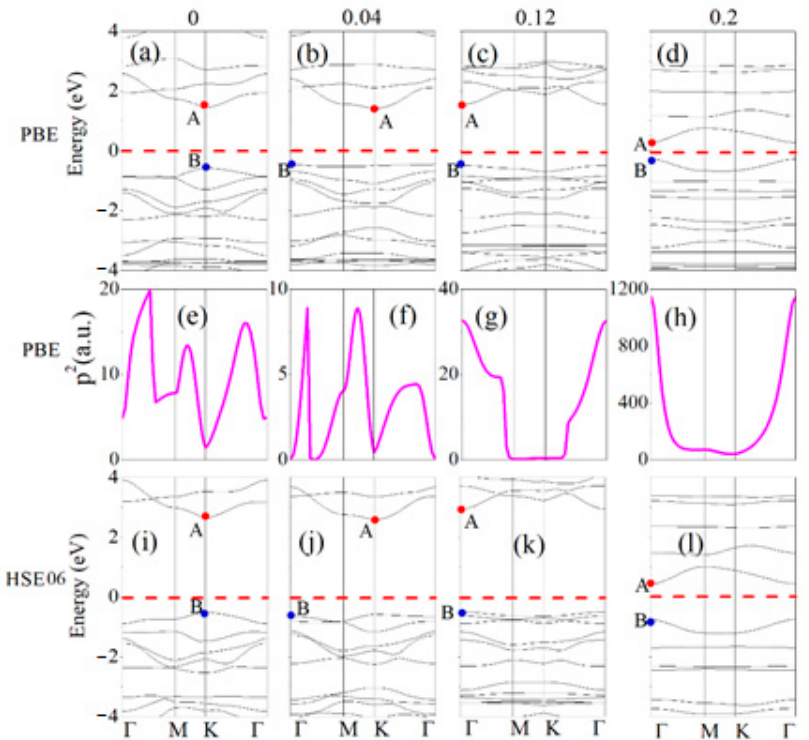
Figure 4. ( a – h ) are PBE calculated band structures and transition matrix elements of the CO 2 adsorbed g-C 3 N 4 system at 0, 0.04, 0.12 and 0.2 strain. ( i–l ) are HSE06 calculated band structures of the CO 2 adsorbed g-C 3 N 4 system at 0, 0.04, 0.13 and 0.2 strain. The CBM and VBM band edge positions denoted by the red and blue points, which are signed with A and B, respectively. The Fermi energy is set at zero energy and indicated by the red dashed line.